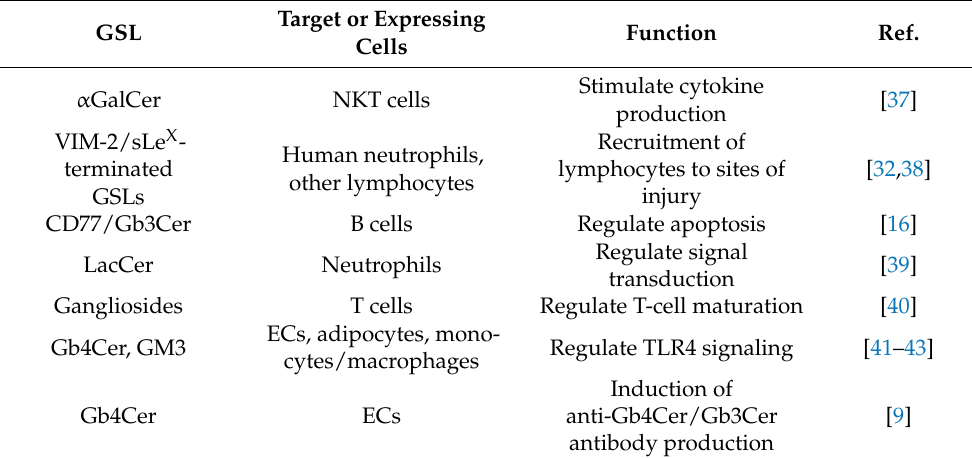
Table 2. Functions of GSLs in mammalian immune